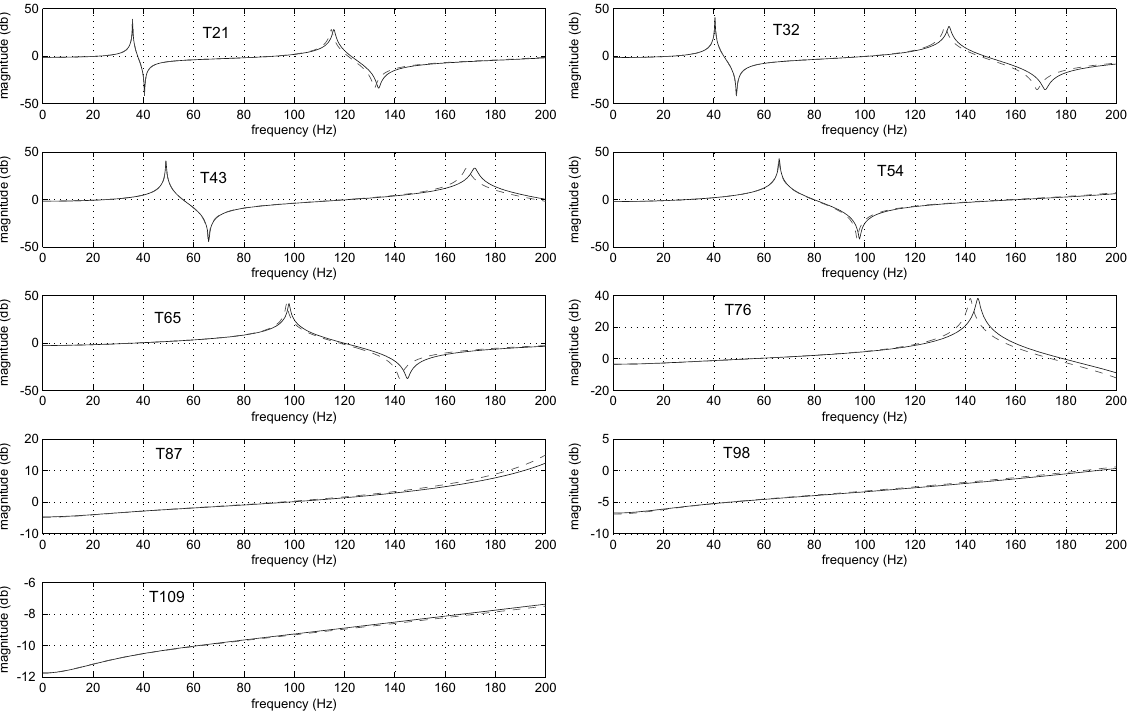
Fig. 5. Transmissibility functions for undamaged (full line) and damaged (dashed line) case for the first loading condition, between responses at DOF 1 and DOF 2 (top left), DOF 2 and DOF 3 (top right) ... DOF 9 and DOF 10 (bottom